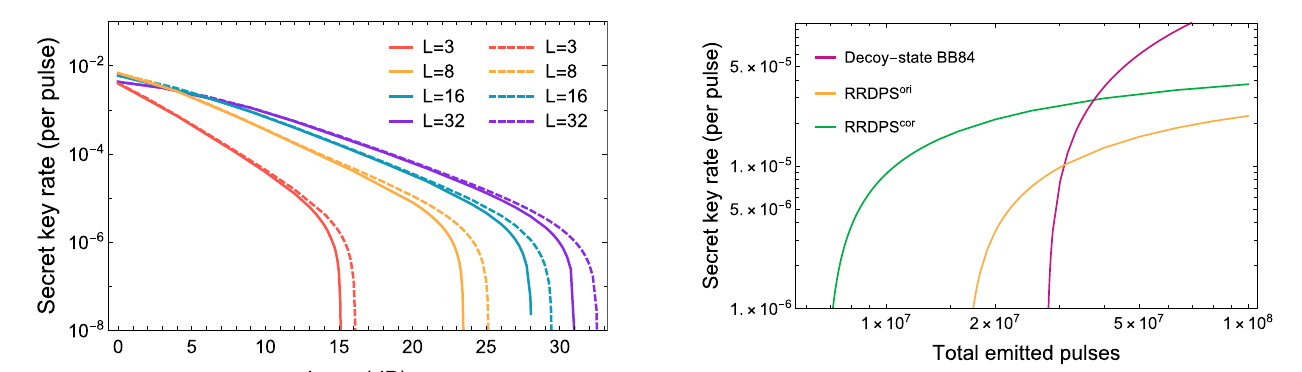
Fig. 3 Comparison with other protocols. The full lines show the secret key rate versus total emitted pulses. The red curve represents the fi nite-key analysis of decoy-state BB84 protocol in ref. 18 . The yellow curve represents the original fi nite-key analysis of RRDPS protocol given in ref. 5 . The green curve represents the key rate based on our corollary. We set L = 53. The total security parameter of the fi nal key is ϵ tot : = 10 − 10 . The channel loss is fi xed at 20dB, dark counts rate is d = 10 − 6 per pulse, and the misalignment of measurement is e mis = 0.015. The ef fi ciency of error correction ξ is 1.1.